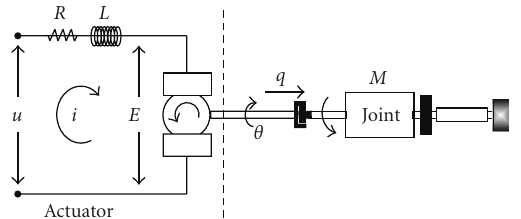
Figure 3: Electric schema for DC motor. Each robot joint is motorized by direct current motor.